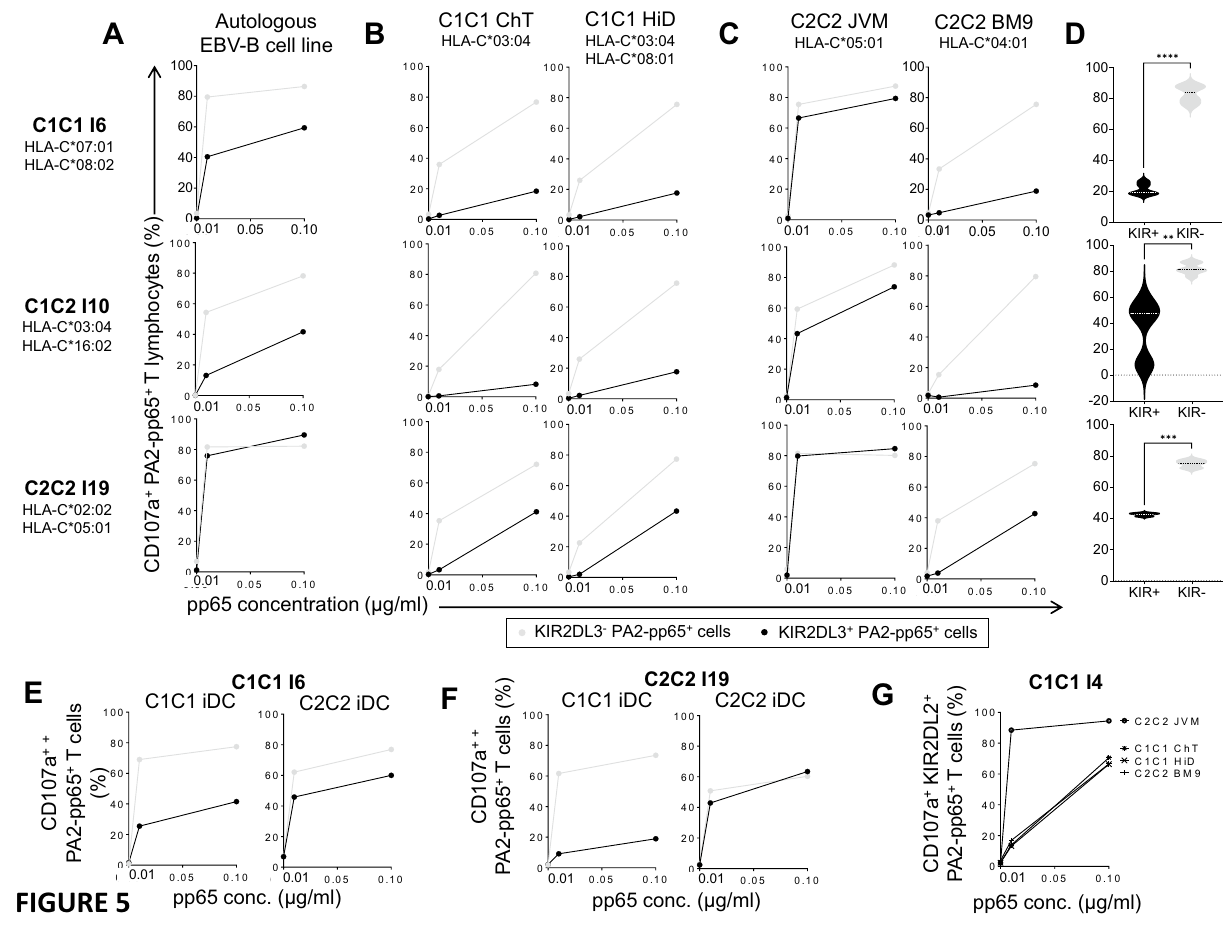
Figure 5. KIR2DL3 inhibits conventional T lymphocyte response against target cells expressing C1 ligands and HLA-C*04 C2 ligand with higher effect on allogeneic than autologous ligands. (A) KIR2DL3 + and KIR2DL3 − HLA-A2-pp65 specific T cell degranulation observed after 5 h incubation in the presence of pp65 (0, 0.01, and 0.1 µg/ml) loaded autologous EBV-B cell line, (B) allogeneic C1C1 ChT (HLA-C*03:04) and HiD (HLA- C*03:04; C*08:01) EBV-B cell lines, (C) C2C2 JVM (HLA-C*05:01) and BM9 (HLA-C*04:01) EBV-B cell lines at an effector: target ratio of 10:1 for three representative individuals (C1C1 I6, C1C2 I10 and C2C2 I19). Experiments were performed from 5 C1C1, 3 C1C2 and 2 C2C2 blood donors. (D) Violin plots of KIR2DL3 + and KIR2DL3 − HLA-A2-pp65 specific T cell degranulation observed after 5 h incubation in the presence of pp65 (0.1 µg/ml) loaded C1C1 EBV-B cell lines for 5 C1C1, 3 C1C2 and 2 C2C2 blood donors. Paired t test was used to evaluate whether values between KIR2DL3 + and KIR2DL3 − T cell degranulation were significantly different. **, *** and ****indicate p < 0.01, p < 0.001 and p < 0.0001 respectively. (E) KIR2DL3 + and KIR2DL3 − HLA-A2-pp65 specific T cell degranulation observed after 5 h incubation in the presence of pp65 (0, 0.01, and 0.1 µg/ml) loaded allogeneic C1C1 and C2C2 immature dendritic cells at an effector: target ratio of 10:1 for one representative C1C1 (I6) and (F) C2C2 individuals (I19). (G) KIR2DL2 + HLA-A2-pp65 specific T cell degranulation observed after 5 h incubation in the presence of pp65 (0, 0.01, and 0.1 µg/ml) loaded allogeneic C1C1 (ChT, HiD) and C2C2 (JVM, BM9) EBV-B cell lines for one representative C1C1 individual